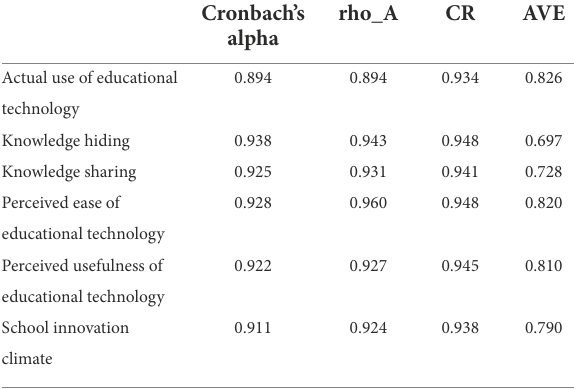
TABLE 3 Construct reliability and validity.